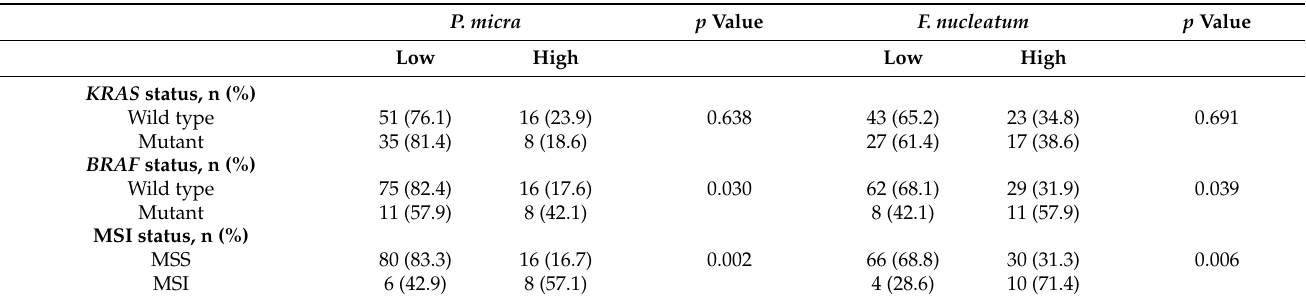
Table 3. Molecular characteristics of study patients in relation to P. micra and F. nucleatum in tumour tissue. P. micra p Value F.